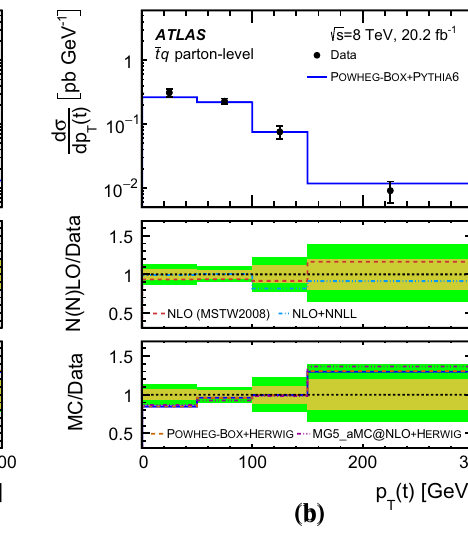
( blue ) line is the NLO + NNLL prediction [25]. The bottom distribution compares the datawiththe MC predictions from Powheg - Box ( orange dashed line ) and MadGraph5 _aMC@NLO ( purple dash-dotted line ). The inner ( yellow ) band in the bottom part of each figure represents the statistical uncertainty of the measurement, and the outer ( green ) band the total